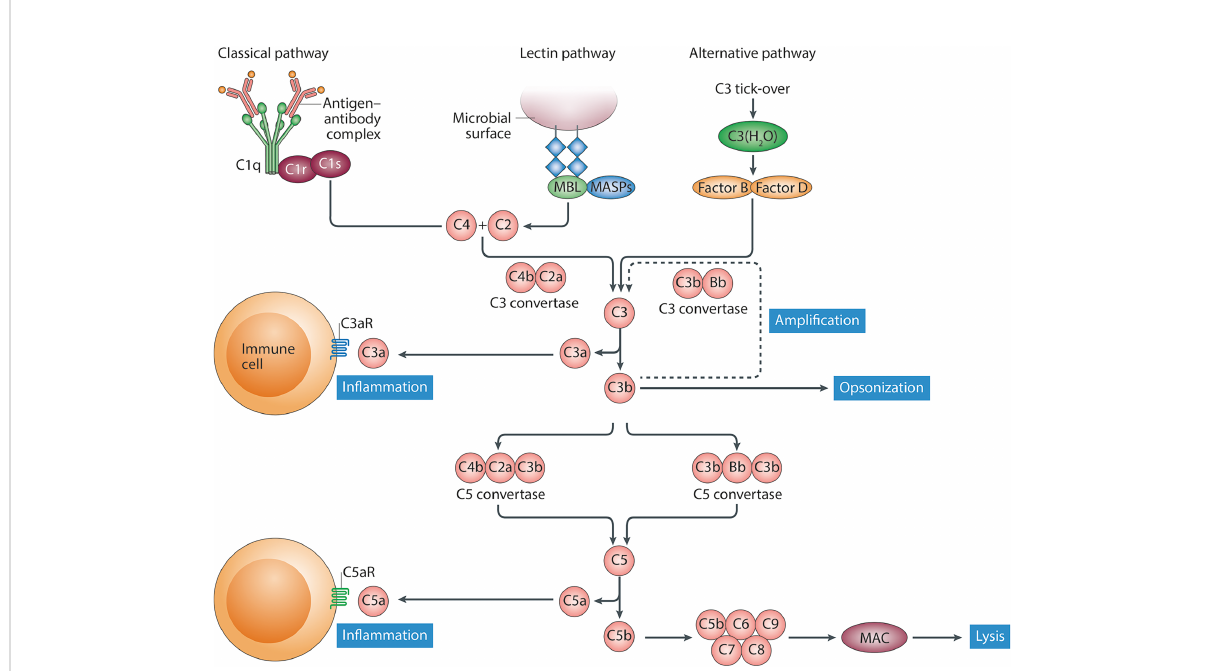
FIGURE 1 Schematic representation of the complement system. The classical pathway of complement activation is activated following to binding of the recognition molecule C1q to ligands such as immune complexes. The lectin pathway is activated following to binding of recognition molecules, such as mannose-binding lectin (MBL), collectins or fi colins, to their ligands, which include carbohydrate structures. Although the alternative pathway is initiated spontaneously, properdin (not shown) might also serve as a recognition molecule for directing activation of this pathway. Following activation via the initiating molecules a cascade of proteolytic activation steps leads to the formation of C3 convertases that cleave C3 into the anaphylatoxin C3a and the opsonin C3b. Next, C5 convertases generate the potent pro-in fl ammatory anaphylatoxins C5a and C5b, the latter of which, together with C6 – C9, forms the membrane attack complex (MAC). This fi gure was obtained with permission from Trouw, L.A., Pickering, M.C., & Blom, A.M. Nat Rev Rheumatol. 9, 538 – 547 (2017),